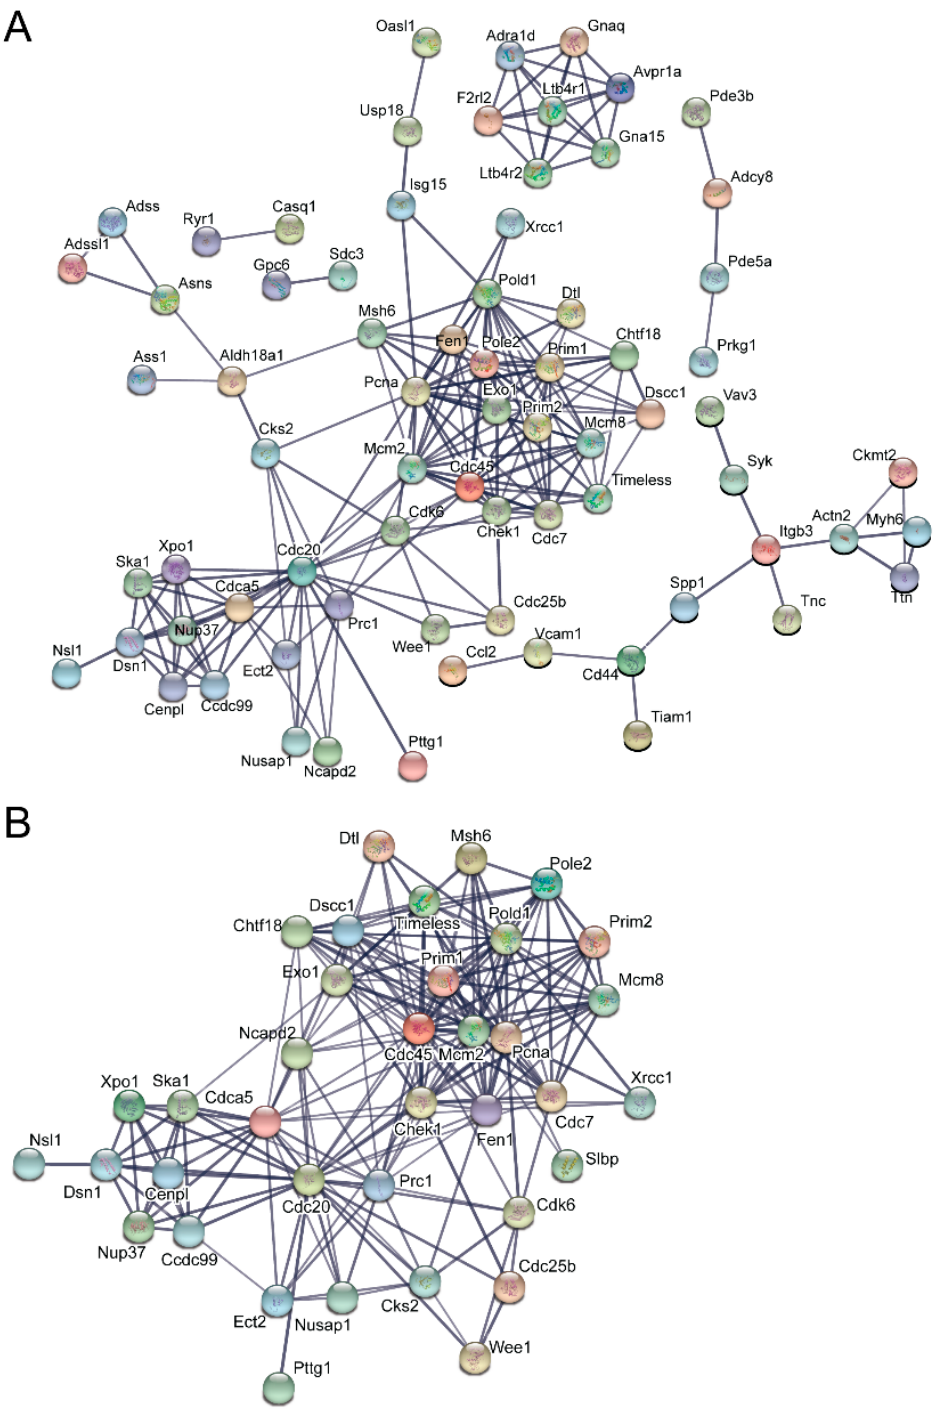
Figure 6. Identification of molecular interaction networks enriched for genes whose expression was altered during the transition from day 1 to day 2 in emerin-null myogenic differentiation. Differentially expressed genes present in only differentiating emerin-null progenitors during the transition from day 1 to day 2 in emerin-null cells were analyzed using STRING to identify interaction networks implicated in their impaired differentiation. ( A ) The most highly enriched and statistically significant and related interaction networks are shown. ( B ) The cell-cycle interaction network was the largest, most enriched network identified by STRING analysis on these samples.